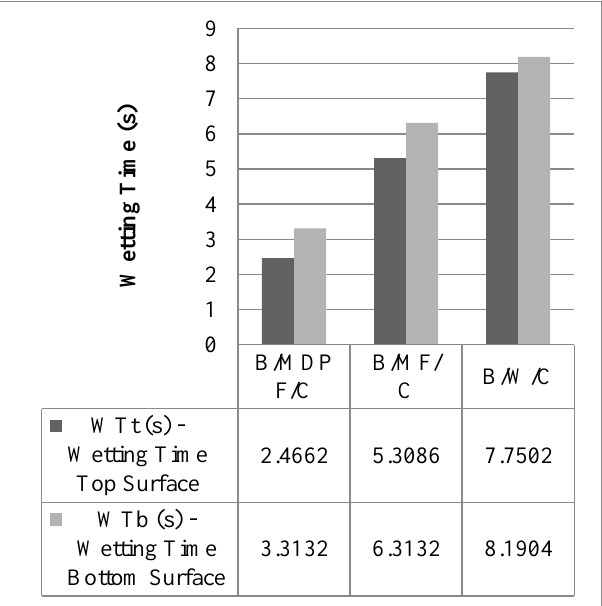
Combination of trilayer knitted fabric structures Sample code